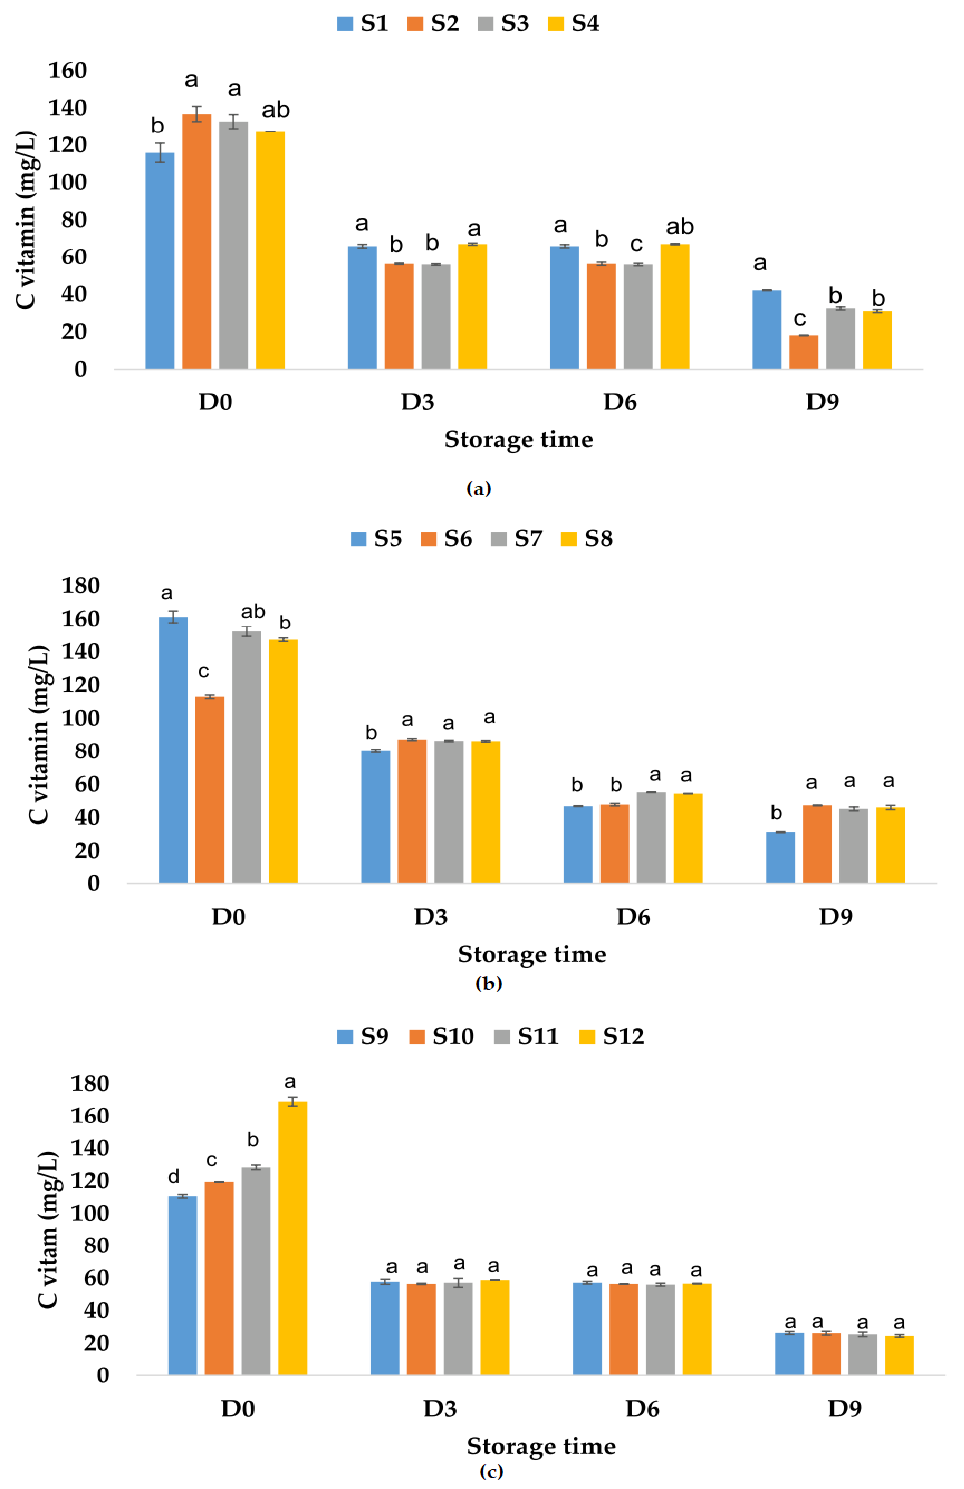
Figure 10. Variation in vitamin C (mg/L) of juice samples during the storage period (D-day) at room temperature (20 ◦ C): ( a ) apple juice samples (S1, S2, S3, S4); ( b ) apple and pumpkin juice samples (S5, S6, S7, S8); ( c ) apple and pomegranate juice samples (S9, S10, S11, S12). Means with different lowercase letter indicate the significant differences ( p < 0.05) among the samples and were performed separately for each day of storage.